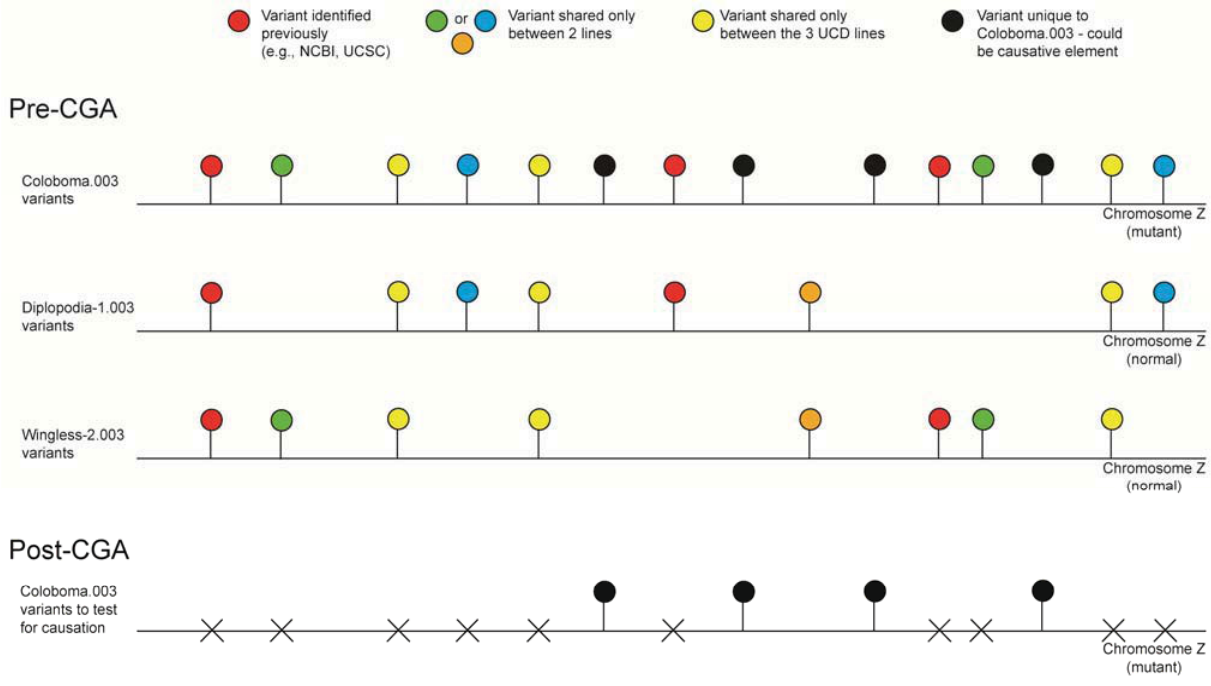
Figure 3. Illustration of the comparative genomic analysis strategy to identify mutant- specific polymorphisms. Comparative genomic analyses (CGA) were conducted to eliminate SNPs and indels shared between two or more of the congenic lines or to previously identified polymorphisms. Those variants not observed in any other genetic line or chicken species were denoted as unique and potential causative elements. An example, to illustrate how this analysis was performed, is shown in reference to the UCD- Coloboma.003 linked region on chromosome Z. All three genetic lines were assessed at the same location for polymorphisms, those variants shared between Co.003 and any other line were removed. Only those elements unique to that region in the Coloboma.003 genetic line are of interest and should be further assessed for